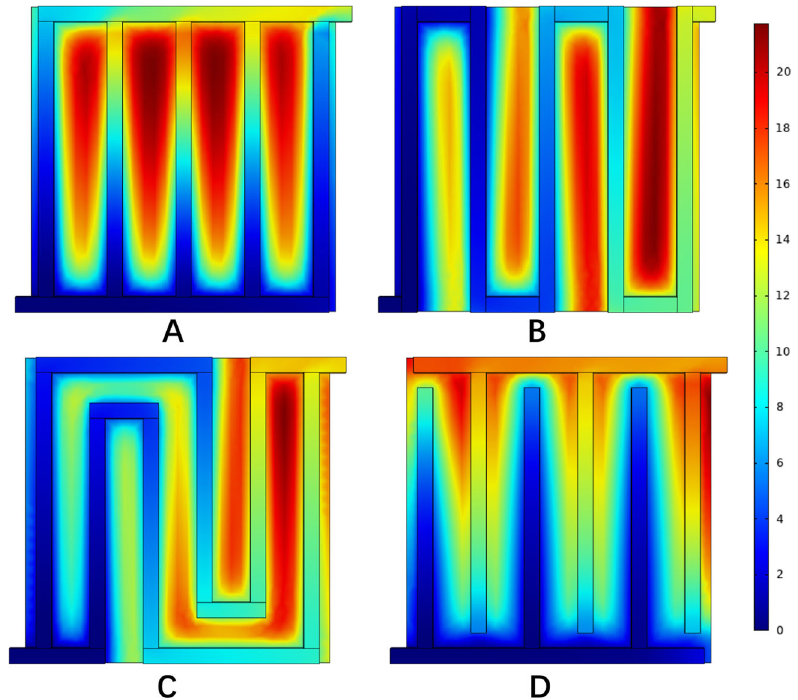
Figure 10. Oxygen mole concentration in anode electrode with different flow fields. ( A ) Parallel, ( B ) ( B ) serpentine, ( C ) multi-serpentine, and ( D ) serpentine, ( C ) multi ‐ serpentine, and ( D ) interdigitate.